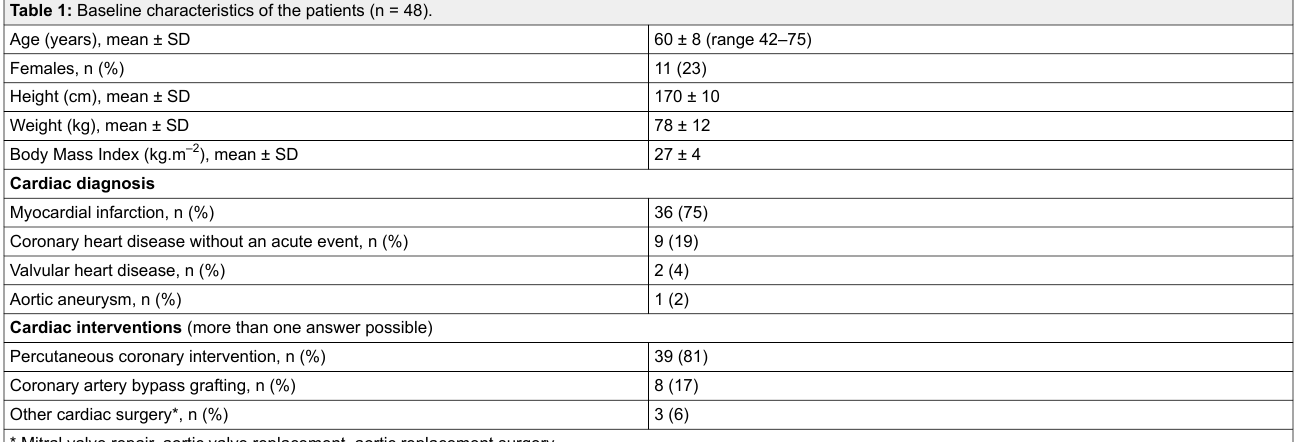
Table 1: Baseline characteristics of the patients (n = 48). Age (years), mean ±